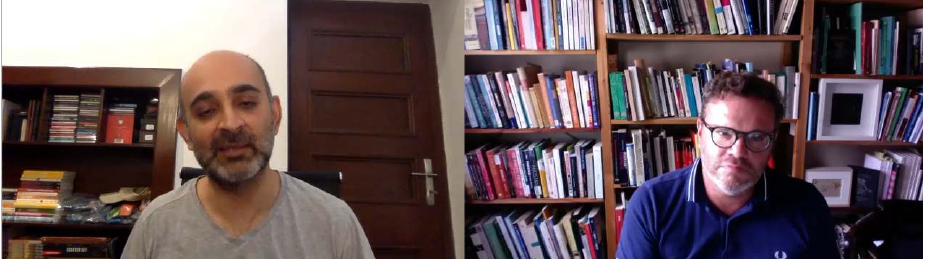
Figure 1. Screen capture of the Zoom interview with Mohsin Hamid and Paul Veyret